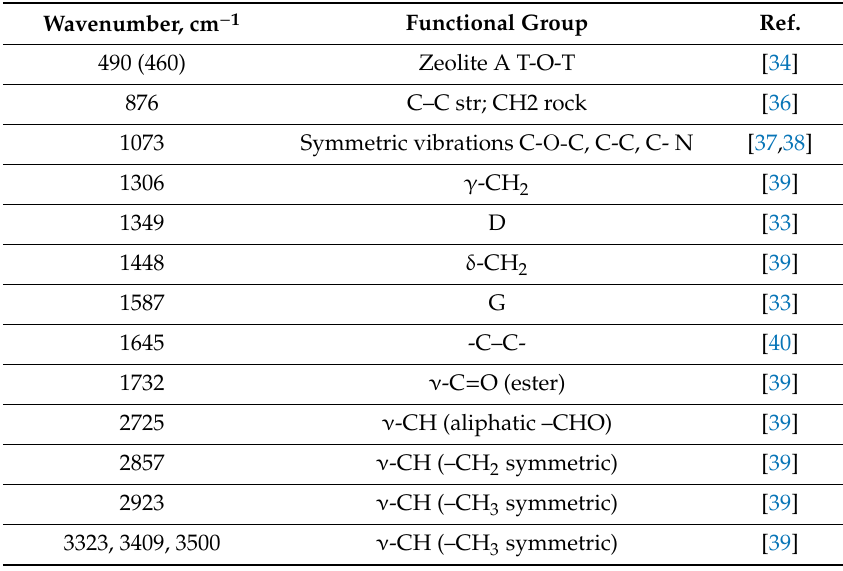
Table 1. Vibrational frequencies of the zeolite 3A–carbon.